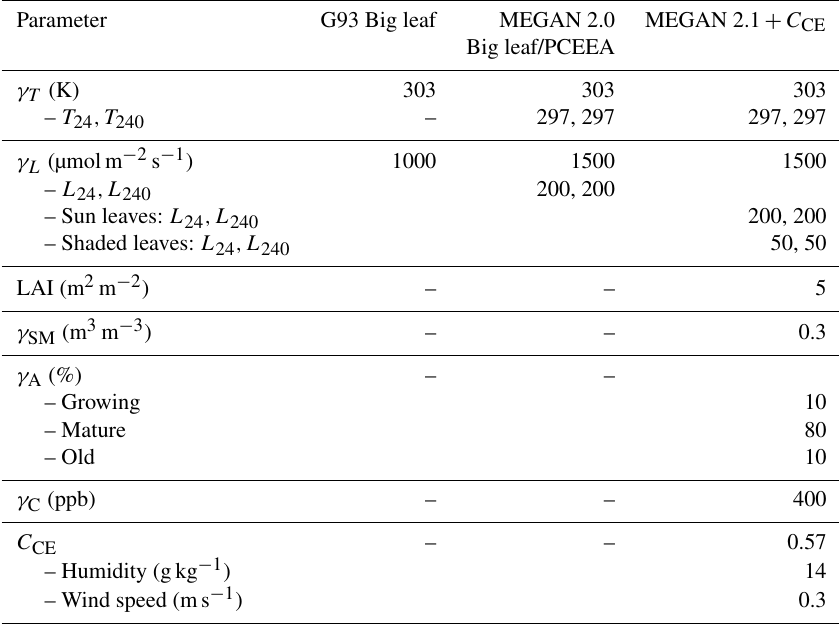
Table 2. List of standard conditions used by each of the emission algorithms in this study.